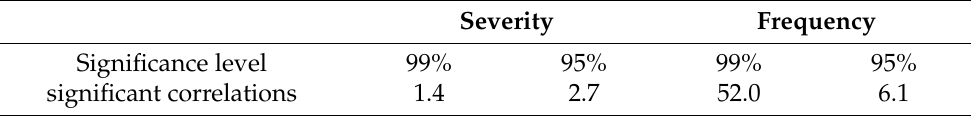
Table 7. Percentage of significant (out of 294) 5-year rolling window correlations: nonCPBP and control data. There are few severity correlations but many frequency